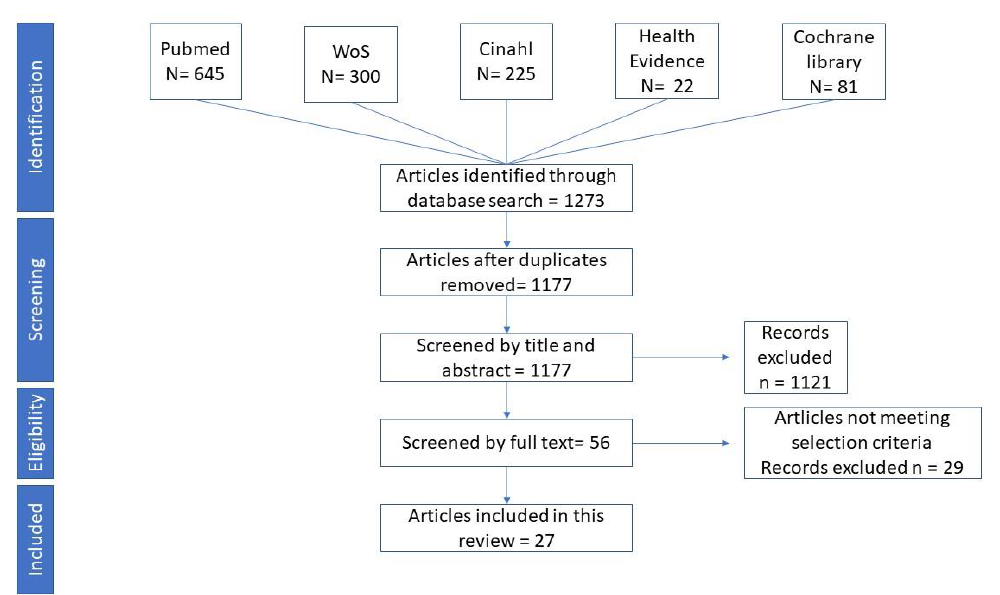
Figure1. Figure 1. Preferred Reporting Items for Systematic Reviews and Meta-Analyses (PRISMA) flow diagram.